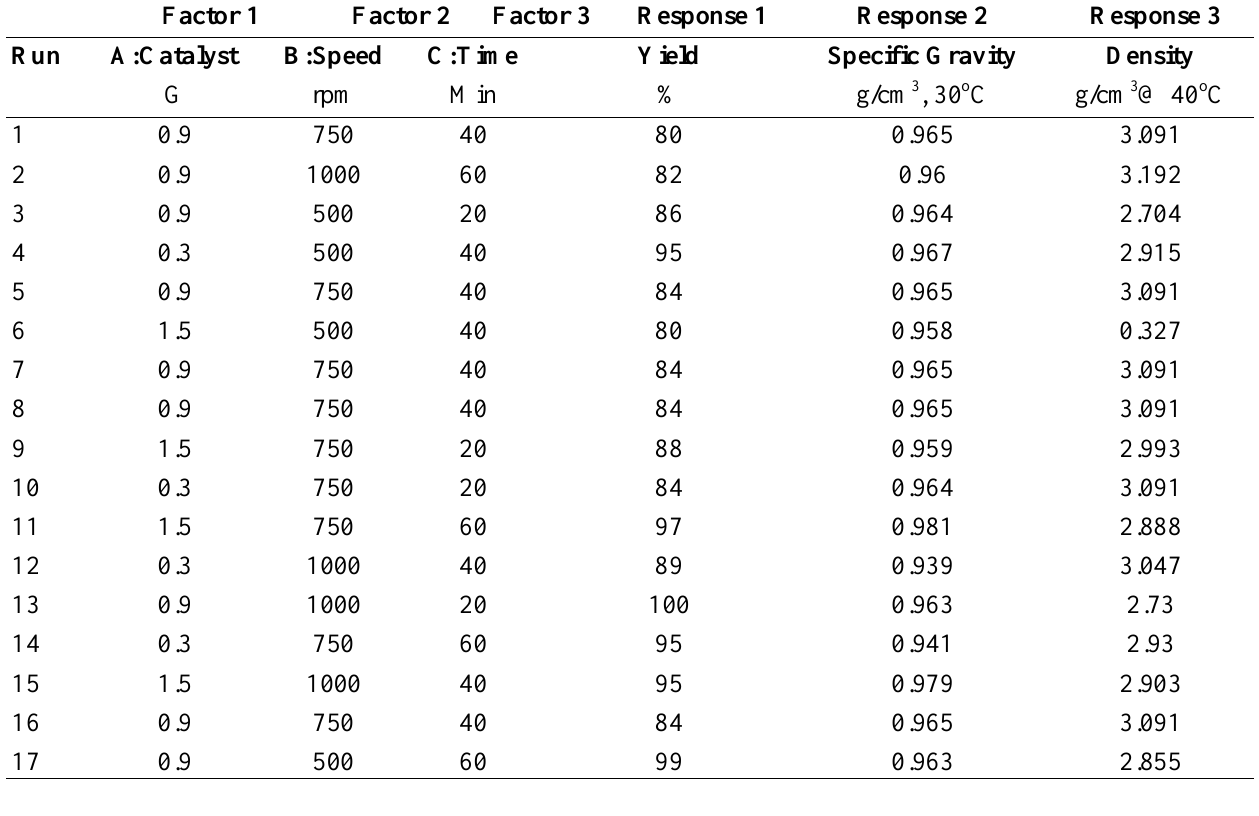
Table 8: Design experimental matrix at different catalyst concentrations, speeds, and